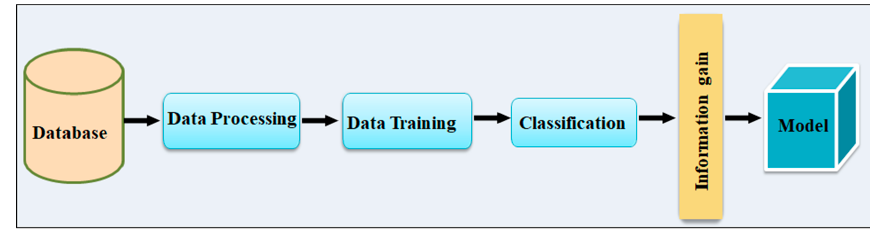
Figure 10. Proposed Architecture for early detection of PD by Cleick et al.